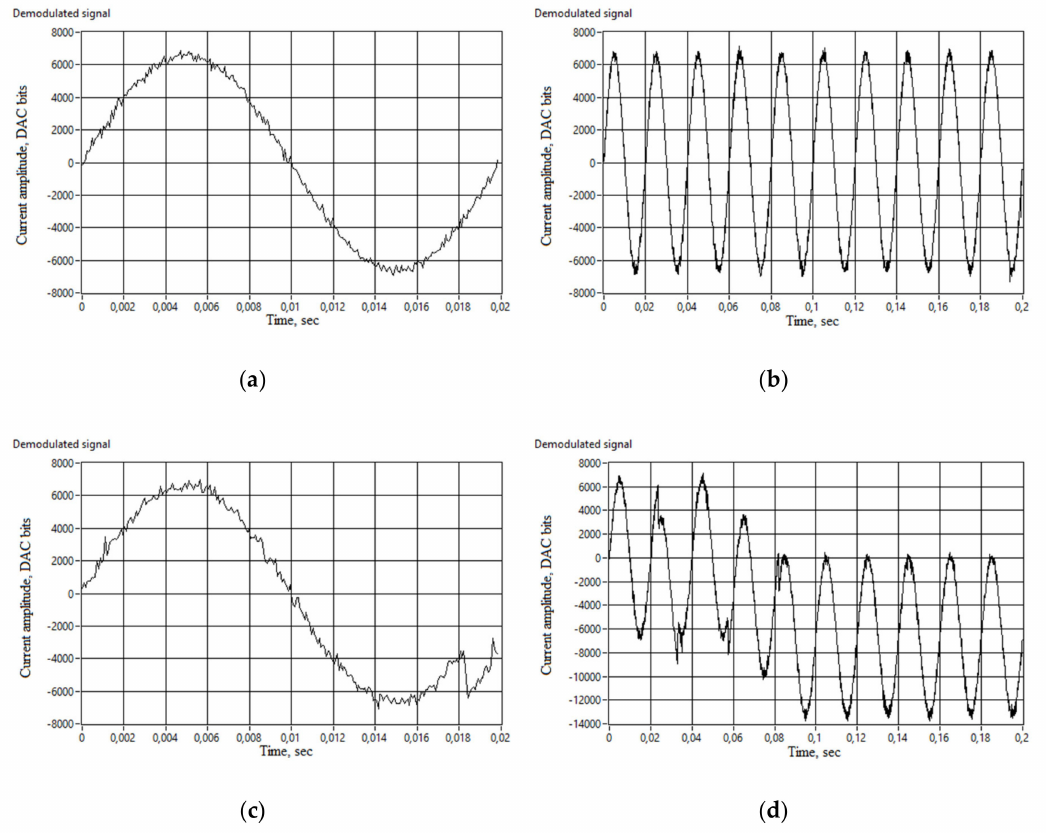
Figure 21. Demodulated current signal vs time: ( a ) Current signal of 2 π radians, 20% noise, 1 period; ( b ) Current signal of 2 π radians, 20% noise, 10 periods; ( c ) Current signal of 2 π radians, 21% noise, 1 period; ( d ) Current signal of 2 π radians, 21% noise, 10